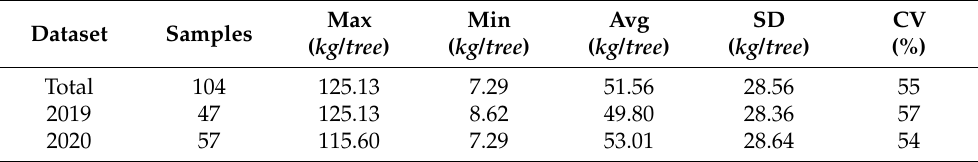
Table 2. Statistical indices of apple fruit yield.